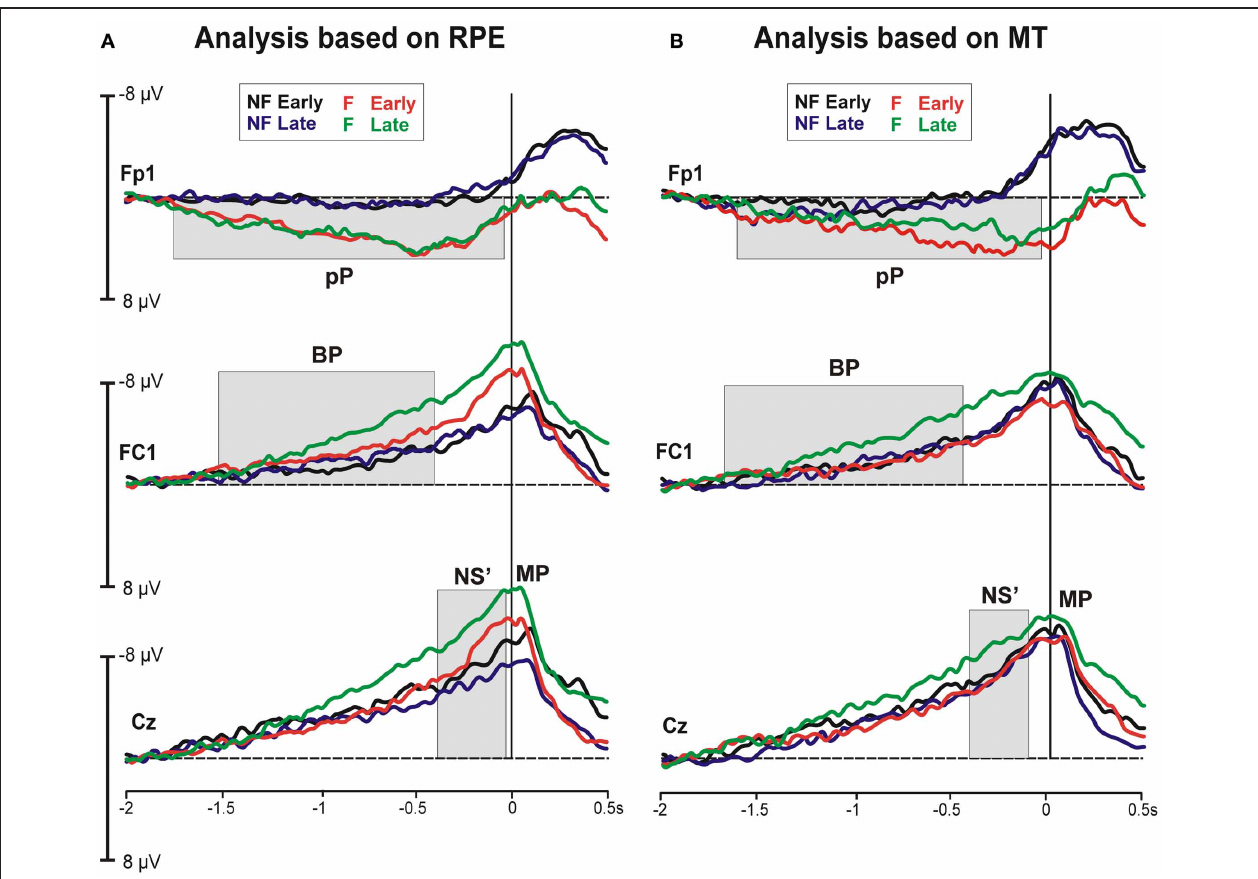
FIGURE 3 | Grand average MRCP waveforms at the prefrontal (Fp1), precentral (FC1), and central (Cz) electrodes based on the rating of perceived effort (A) and the maximal twitch (B) during the early and late blocks of isometric